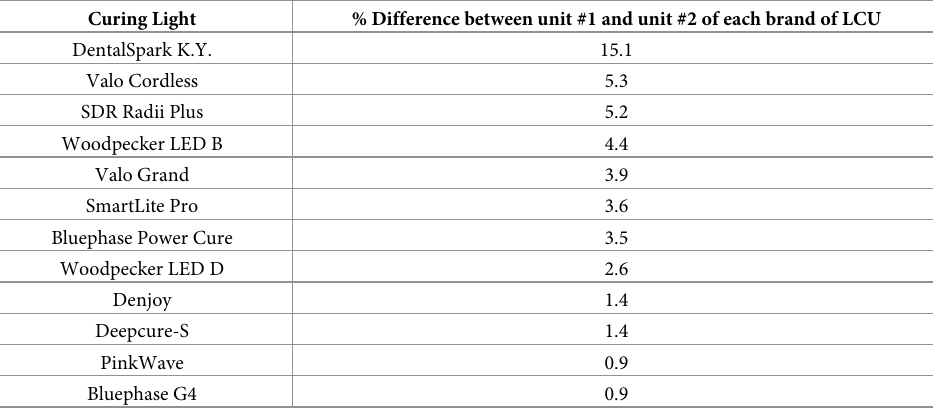
Table 6. Percentage difference between the power values from units #1 and #2 of each LCU recorded using the ‘gold standard’ system. Curing Light % Difference between unit #1 and unit #2 of each brand of LCU DentalSpark